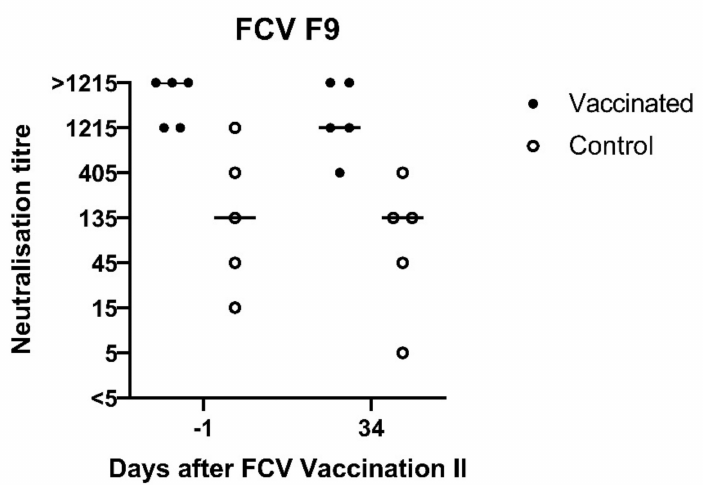
Figure 12. Dot plot of FCV F9 neutralisation titres measured by serum neutralisations assays before and after FCV Vaccination II with FCV F9. The titre is the reciprocal of the serum dilution where 50% or more of the wells show a CPE. Each dot represents the titre of a cat of the vaccine or control group, respectively. The horizontal bar represents the median. Day 34 correspond to day − 1 of FCV Challenge II.